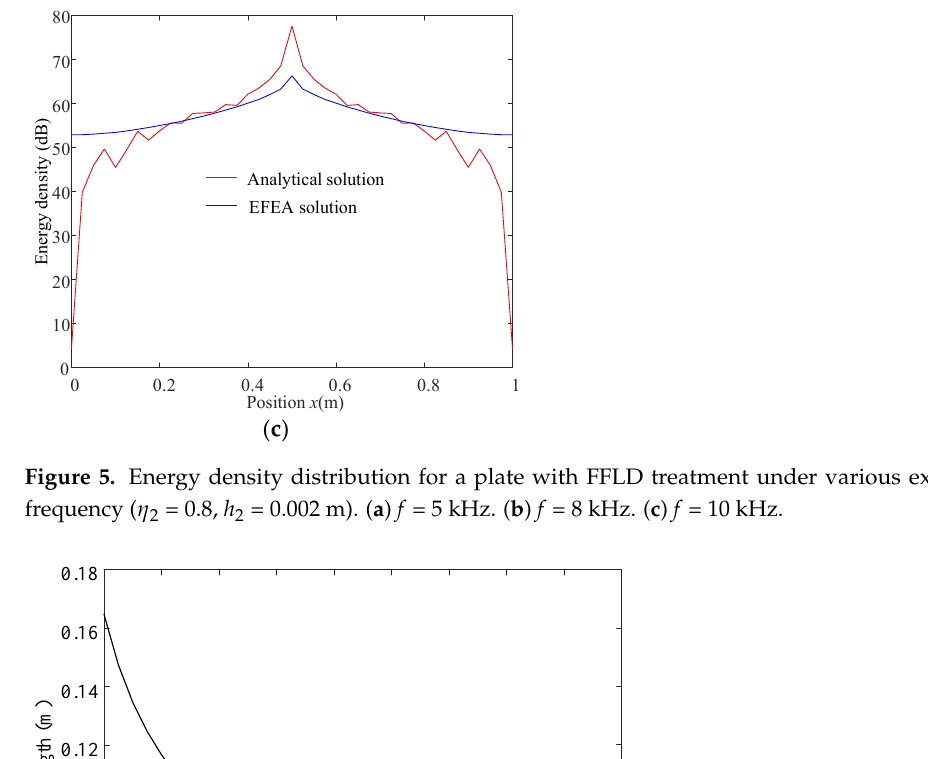
2 = 0.8, h 2 = 0.002 m).